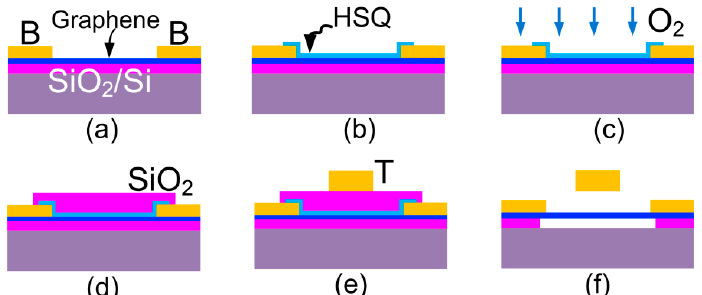
Figure 2. Schematics of fabrication procedure of the graphene NEM switch with local top actuation electrode. T and B denote top and bottom electrodes, respectively. ( a ) Graphene exfoliation and bottom electrodes definition; ( b ) HSQ spin coating and pattering; ( c ) graphene etching in oxygen plasma; ( d ) definition of SiO 2 sacrificial layer; ( e ) definition of top electrode; ( f ) releasing graphene in